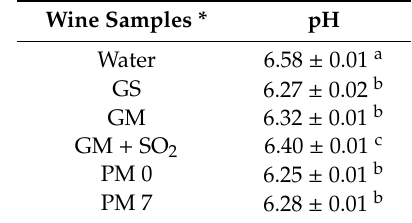
Table 3. The pH of the wine-marinated fish meat ( n = 3).